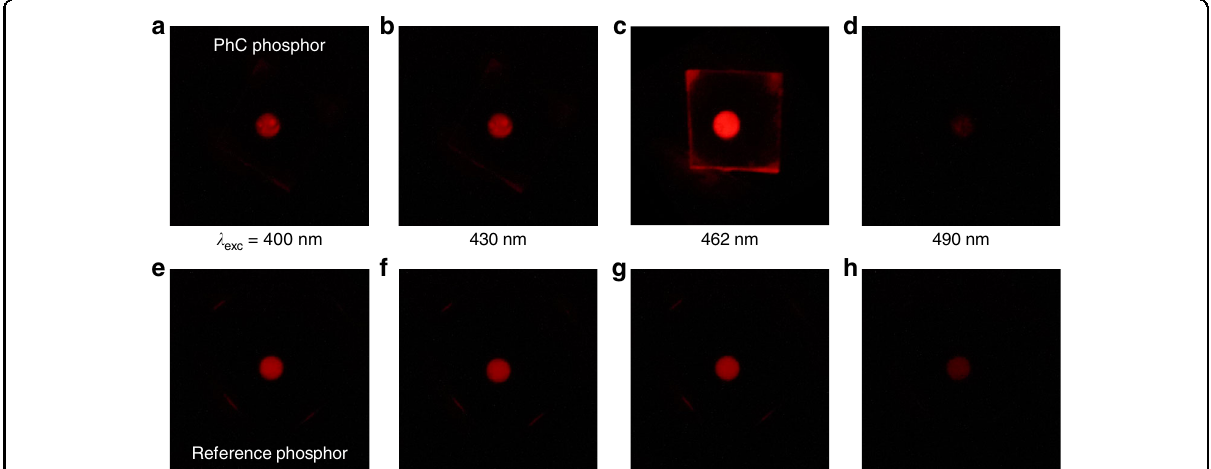
Fig. 4 Visual comparisons of CQD fl uorescence. Acquired photographs of a – d the 2D PhC phosphor and e – h the reference phosphor upon excitation at speci fi c representative wavelengths: a , e λ exc = 400 nm, b , f 430 nm, c , g 462 nm (resonance), and d , h 490 nm. All the images were acquired with a long-pass fi lter inserted to cut off the excitation photons. The sample size, which is outlined in ( c ), is ~1 × 1 cm